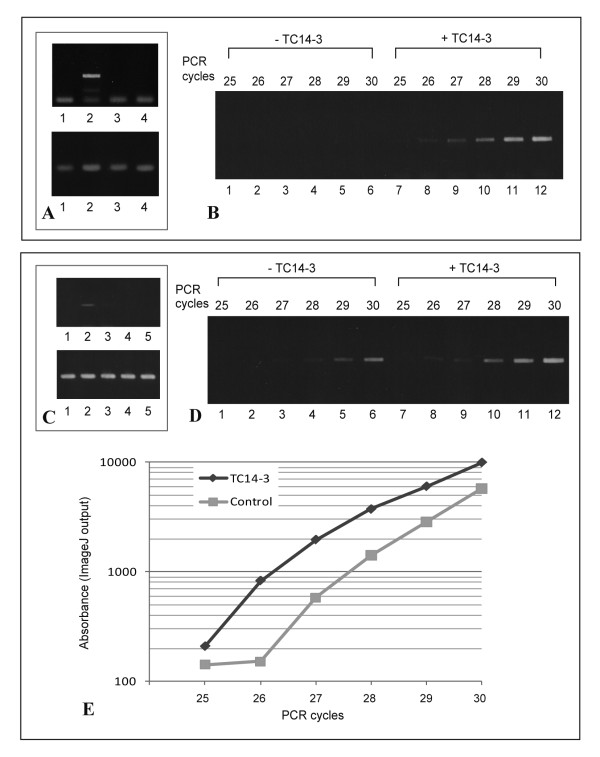
Quantification of in vitro and in vivo PmEed induction by wild-type and mutant TC14-3s. (A, B)Cultured cells. (A)PCR products of PmEed (upper) and Pmβ-actin (lower). Lane 1, control (PBS). Lane 2, wild-type TC14-3. Lane 3, TC14-3T69R. Lane 4, TC14-3E106G. (B)PCR products from 25th to 30th cycle. Lanes 1-6, control (PBS). Lanes 7-12, wild-type TC14-3. (C-E)Aged zooid pieces. (C)PCR products of PmEed (upper) and β-actin (lower). Lane 1, control (PBS). Lane 2, wild type TC14-3. Lane 3, TC14-3K113S.N114E. Lane 4, TC14-3T69R. Lane 5, TC14-3E106G. (D)PCR products from 25th to 30th cycle. Lanes 1-6, control (PBS). Lanes 7-12, wild-type TC14-3. (C)Increasing kinetics of PCR products quantified by ImageJ output.